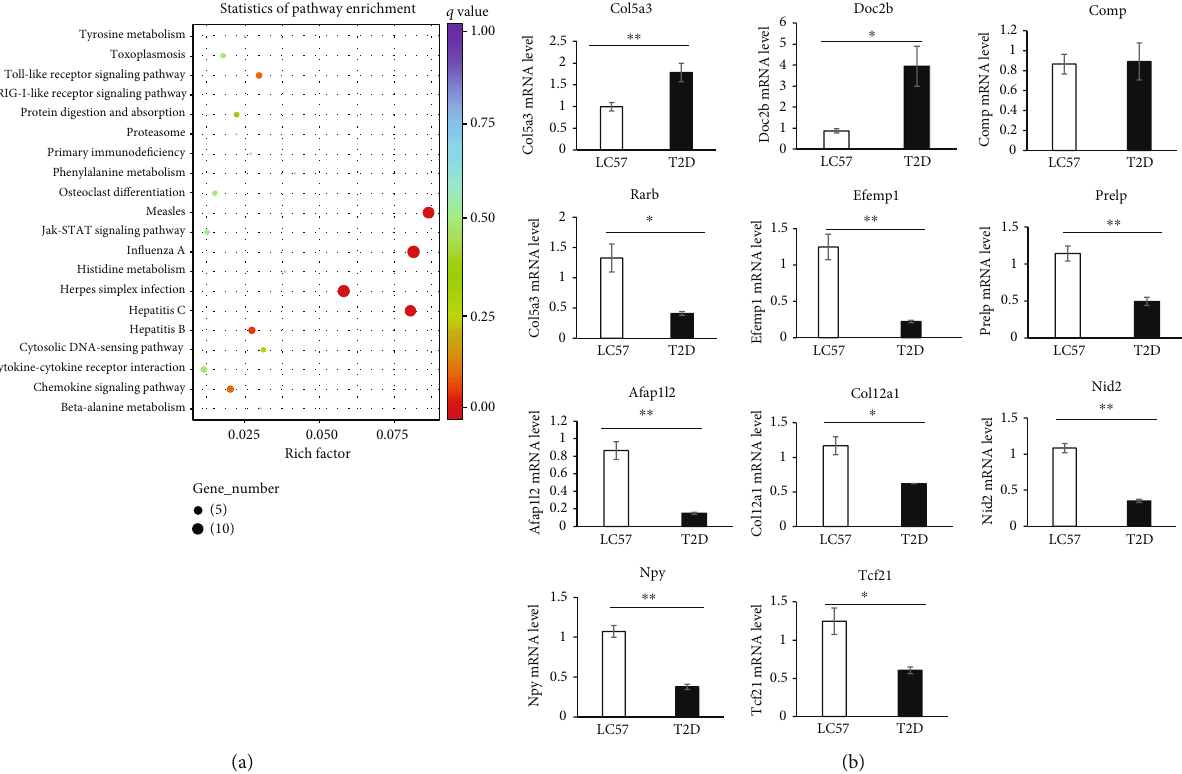
Figure 3: (a) Di ff erential gene KEGG enrichment scatter plot. The size of the dot shows the number of di ff erentially expressed genes in this pathway. (b) Expression of 11 signi fi cant di ff erential genes of C57BL/6 and T2D ASCs tested by RT-PCR. ∗ P < 0 : 05 ; ∗∗ P < 0 : 01